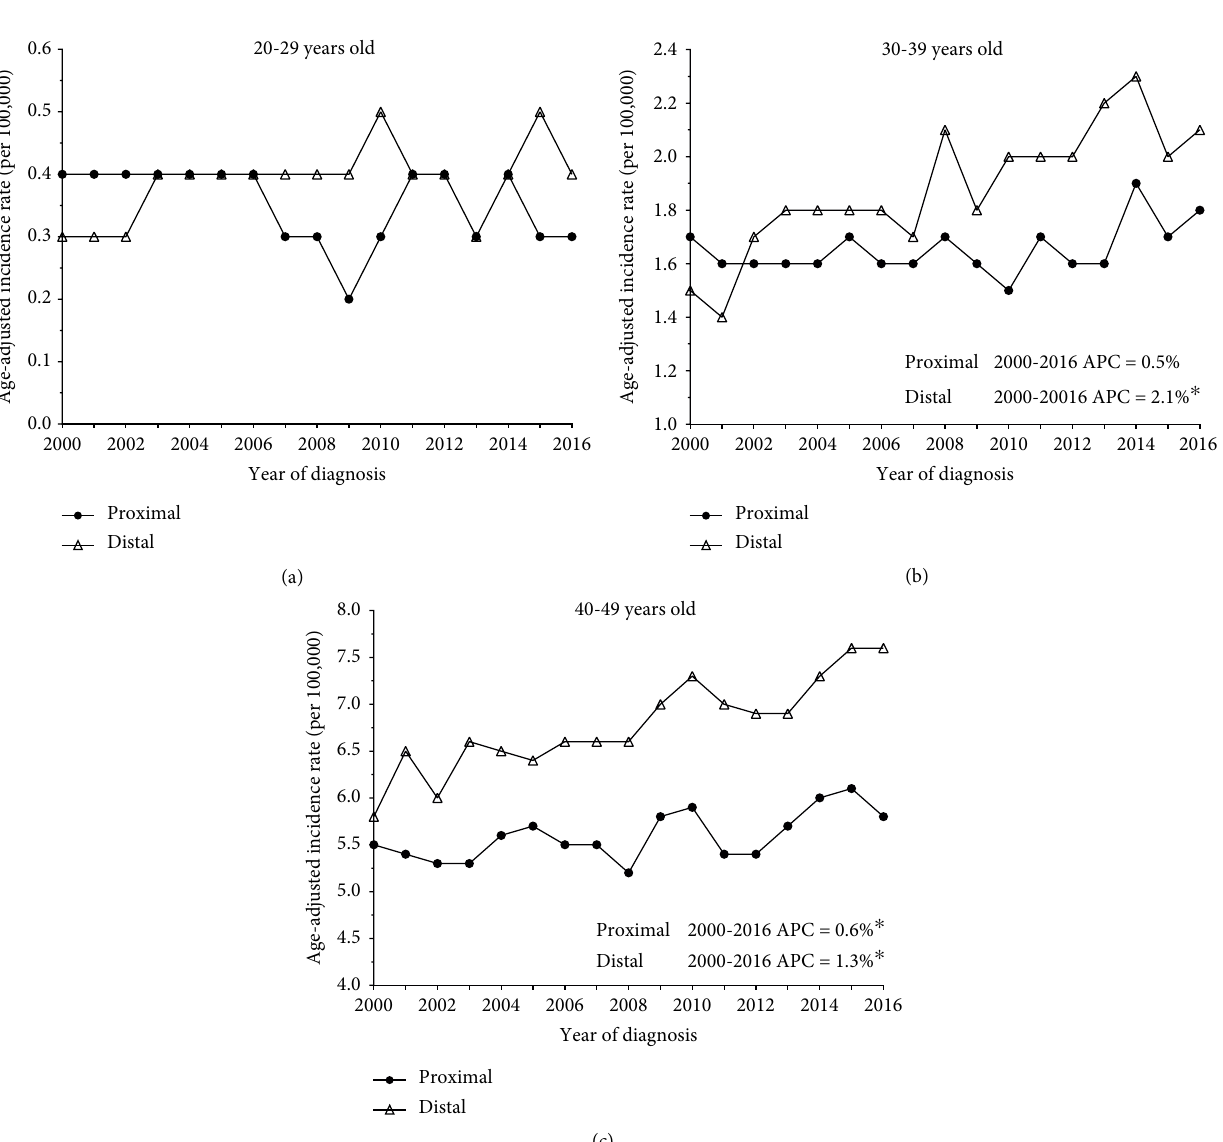
Figure 4: Trends in colon tumor subsite-specific incidence rates stratified by age, 2000–2016. Age-adjusted incidence rates per 100,000 persons from 2000–2016 were derived from SEER18 program data. Colon cancer incidence trends were calculated for individuals age 20–29 (a), 30–39 (b), and 40–49 (c). Annual percentage change (APC) are quantifications of the changes in trends. Asterisks ( ∗ ) designate statistical significance calculated in the permutation